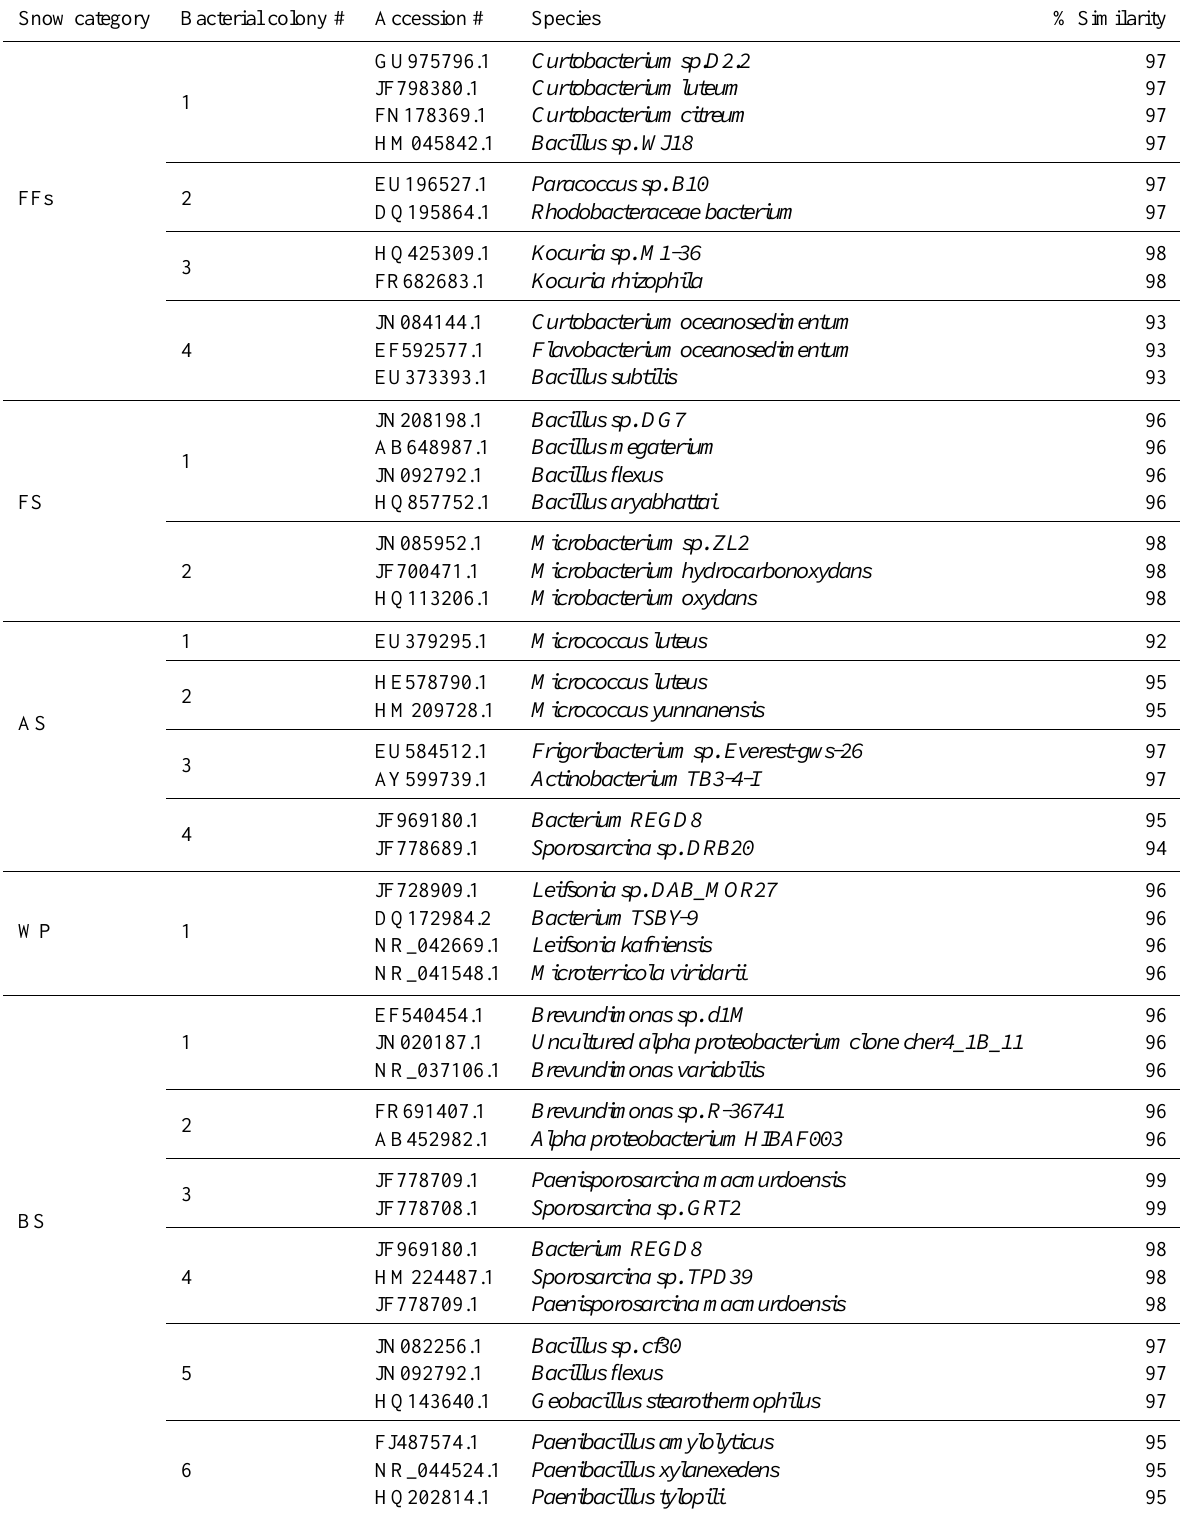
Table 2. Identification of viable cultivable bacteria in Arctic samples. Some of the bacterial colonies were identified in each snow categories: accumulated snow (AS), blowing snow (BS), fresh snow (FS), windpack (WP), and frost flowers (FFs); accession number, the nearest neighbor found in the database, a unique identifier given to a DNA sequence; identified species; and % similarity, the ratio of identical query bases to known bases in the